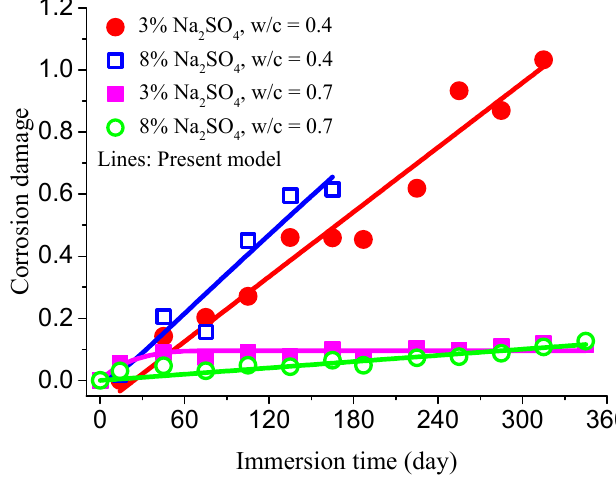
Figure 8. Dynamic modulus evolution of concrete specimens ( w / c = 0.7) after eliminating hydration in different sulfate solution.